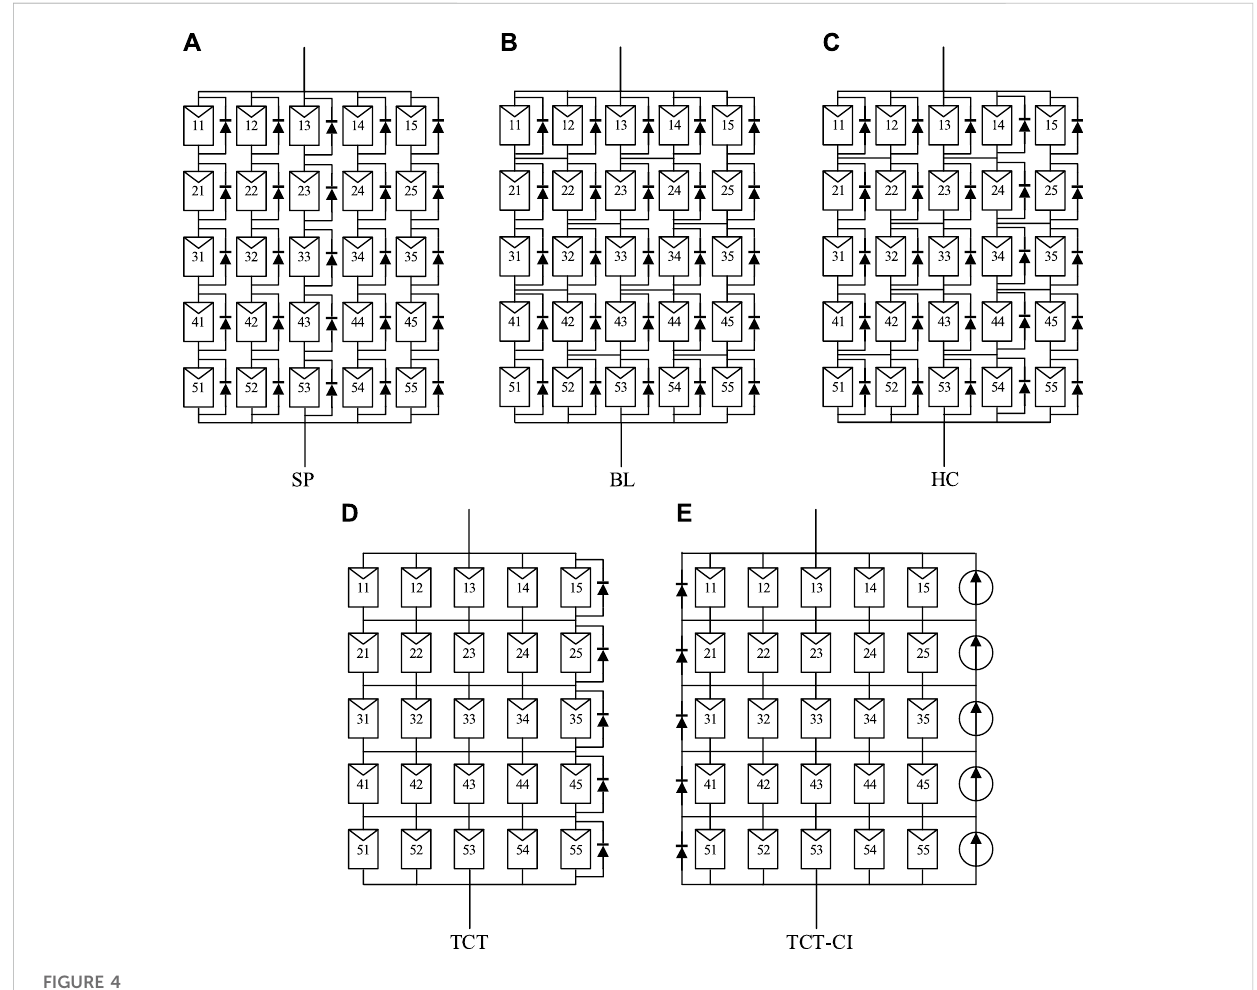
FIGURE 4 Several topologies of simulation. (A) SP, (B) BL, (C) HC, (D) TCT, (E) TCT-CI.